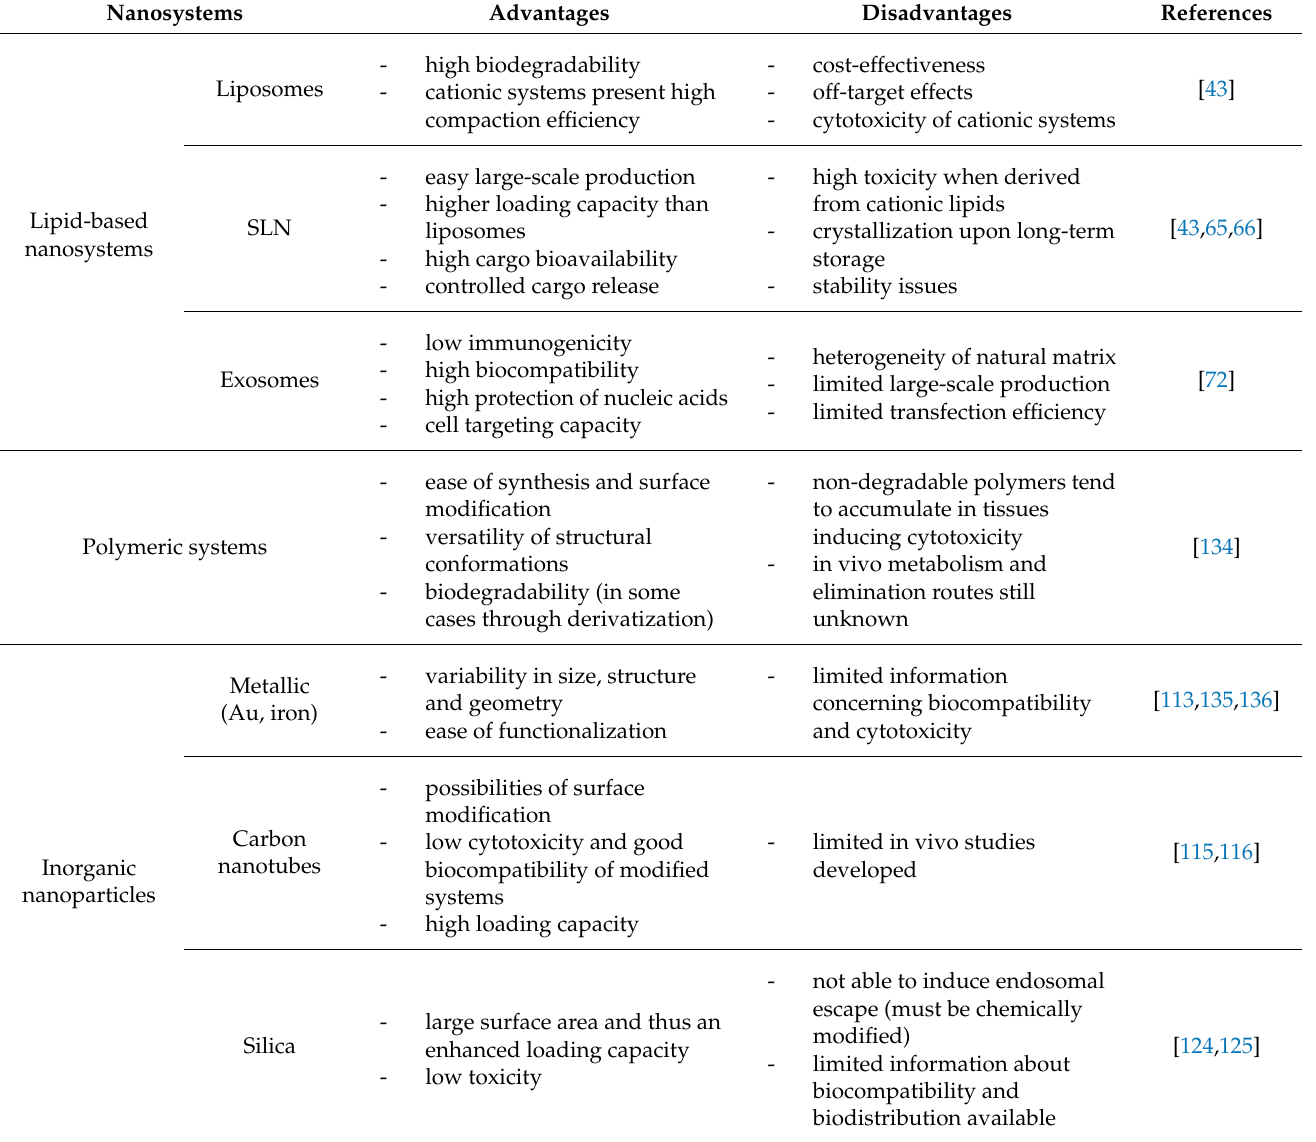
Table 2. Advantages and disadvantages of nanosystems used for RNA